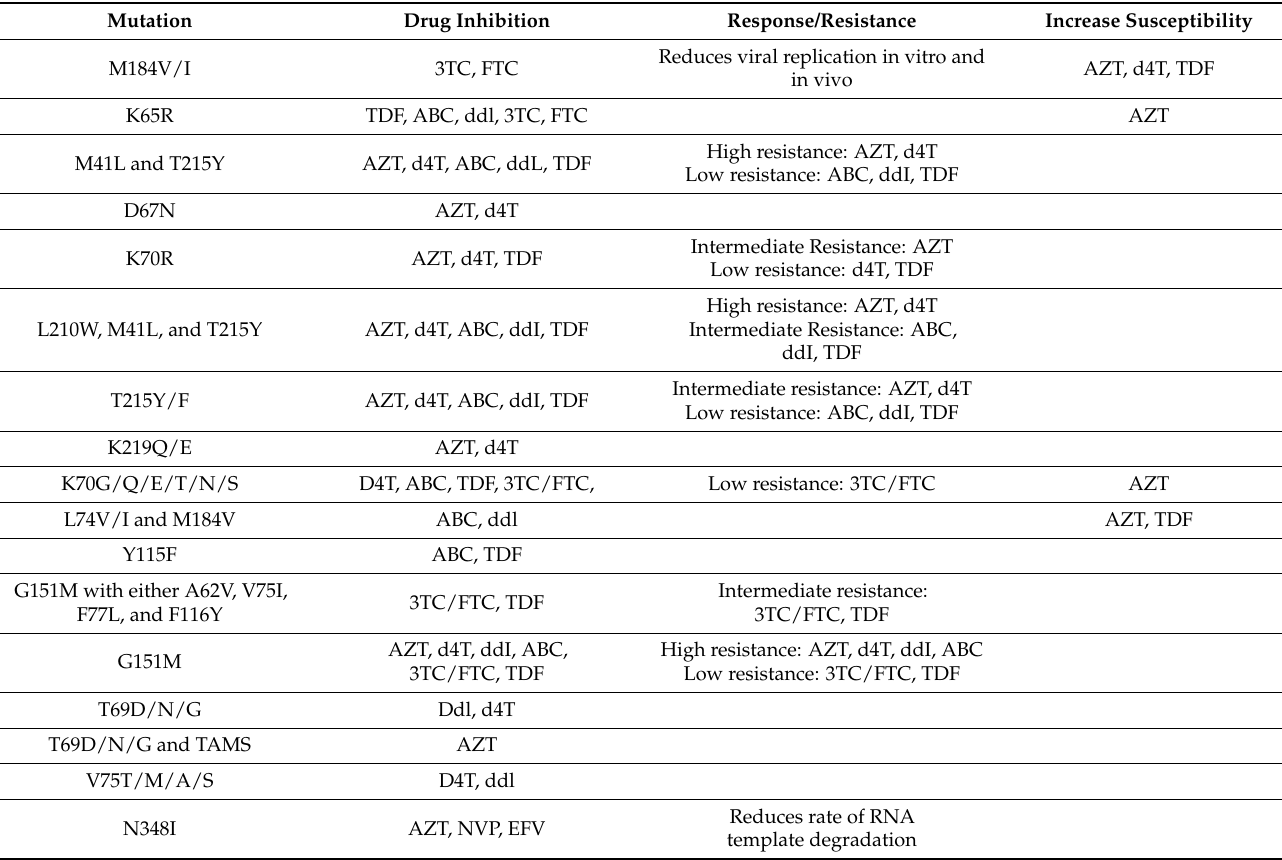
Table 4. Mutation patterns commonly found due to NRTI and NNRTI